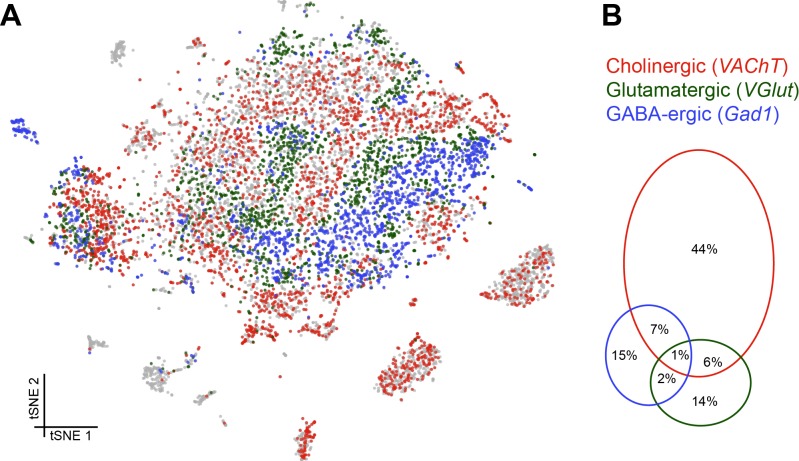
Distribution of fast-acting neurotransmitters.(A) t-SNE plot showing the distribution of cells expressing vesicular acetylcholine transporter (VAChT, cholinergic neurons), vesicular glutamate transporter (VGlut, glutamatergic neurons) and glutamic acid decarboxylase 1 (Gad1, GABA-ergic neurons). For graphical reasons only cells expressing each marker above a log normalized value of 2 are shown. (B) Quantification of cells expressing markers displayed in A. The difference to 100% are cells that did not express any of the three markers.